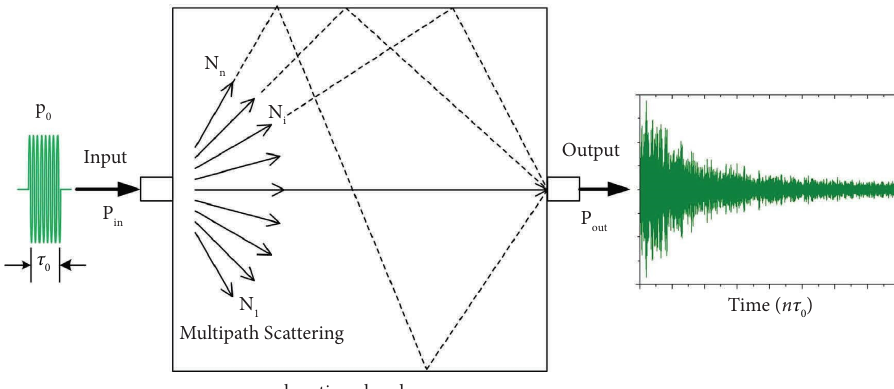
Figure 1: Te multipath scattering principle of a rectangular reverberation chamber (the rectangular reverberation chamber has a larger cross-section compared with the wavelength of the operating wavelength frequency).